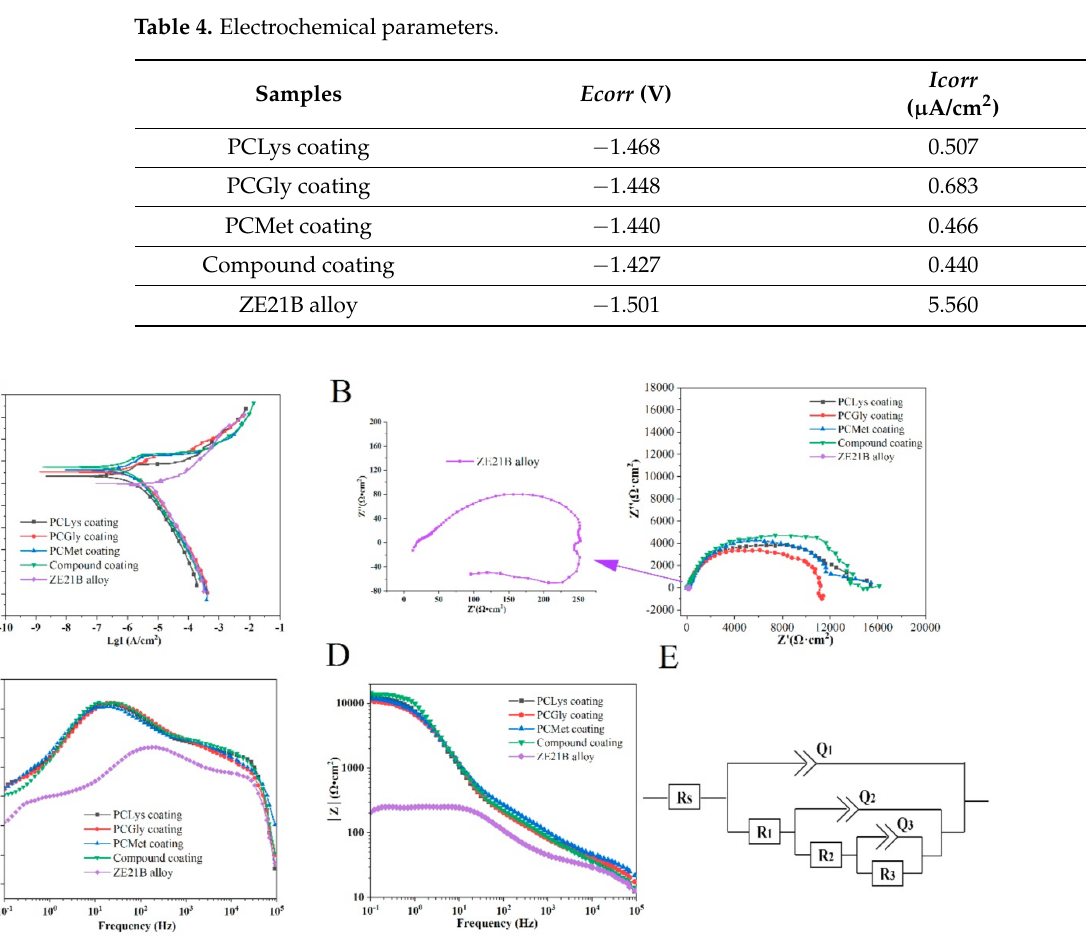
Figure 7. ( A ) Polarization curve diagram, ( B ) EIS spectrum diagram, ( C ) phase angle—bode diagram, ( D ) impedance modulus—bode diagram, ( E ) equivalent circuit